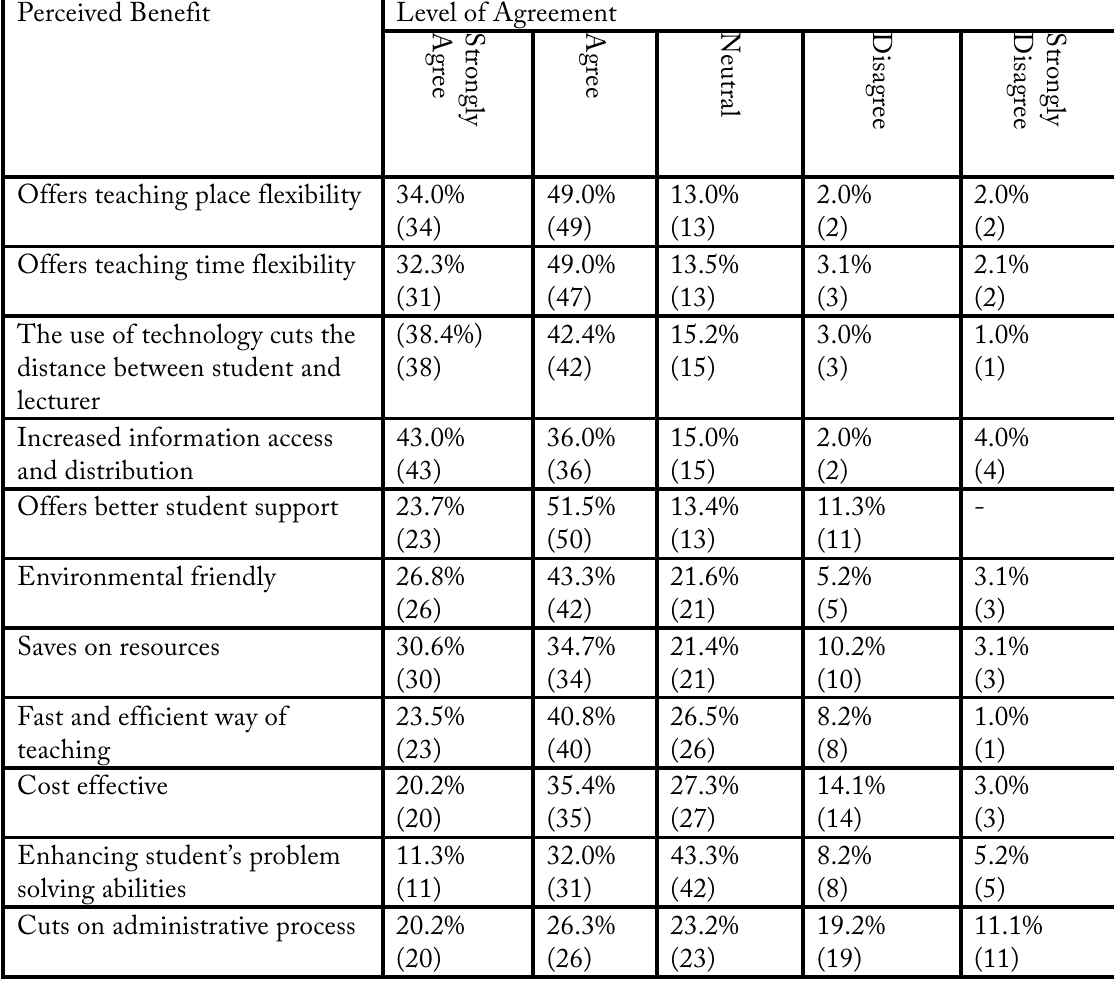
Table 8: Perceived benefits of emerging technologies Perceived Benefit Level of